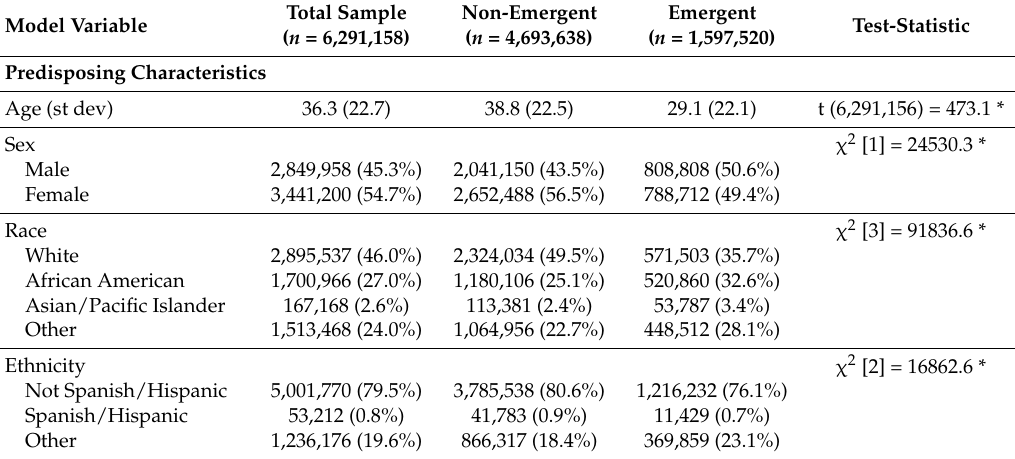
Table 1. Predisposing characteristic, enabling resource, and need comparisons by type of emergency department